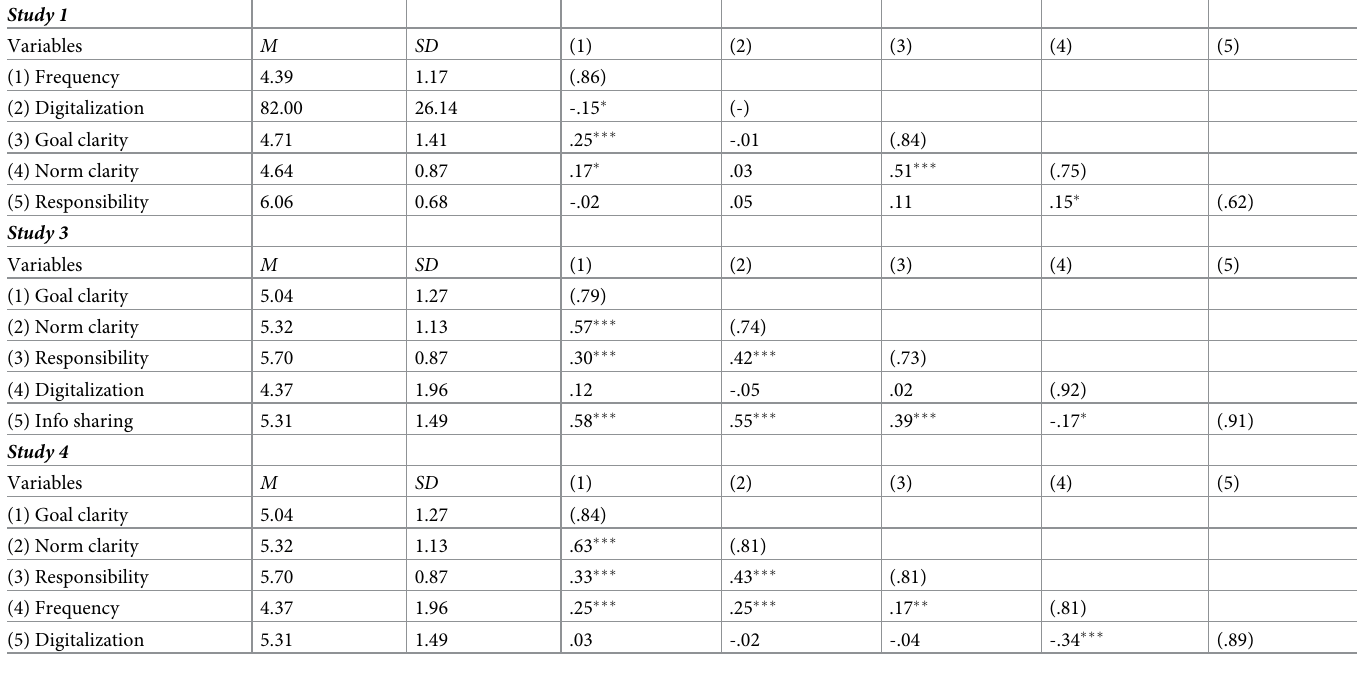
Table 1. Means, standard deviations, correlations (Pearson’s r), and Cronbach’s α (in brackets on the diagonal) of Study 1 ( N = 200), Study 3 ( N = 178) and Study 4 ( N = 261).